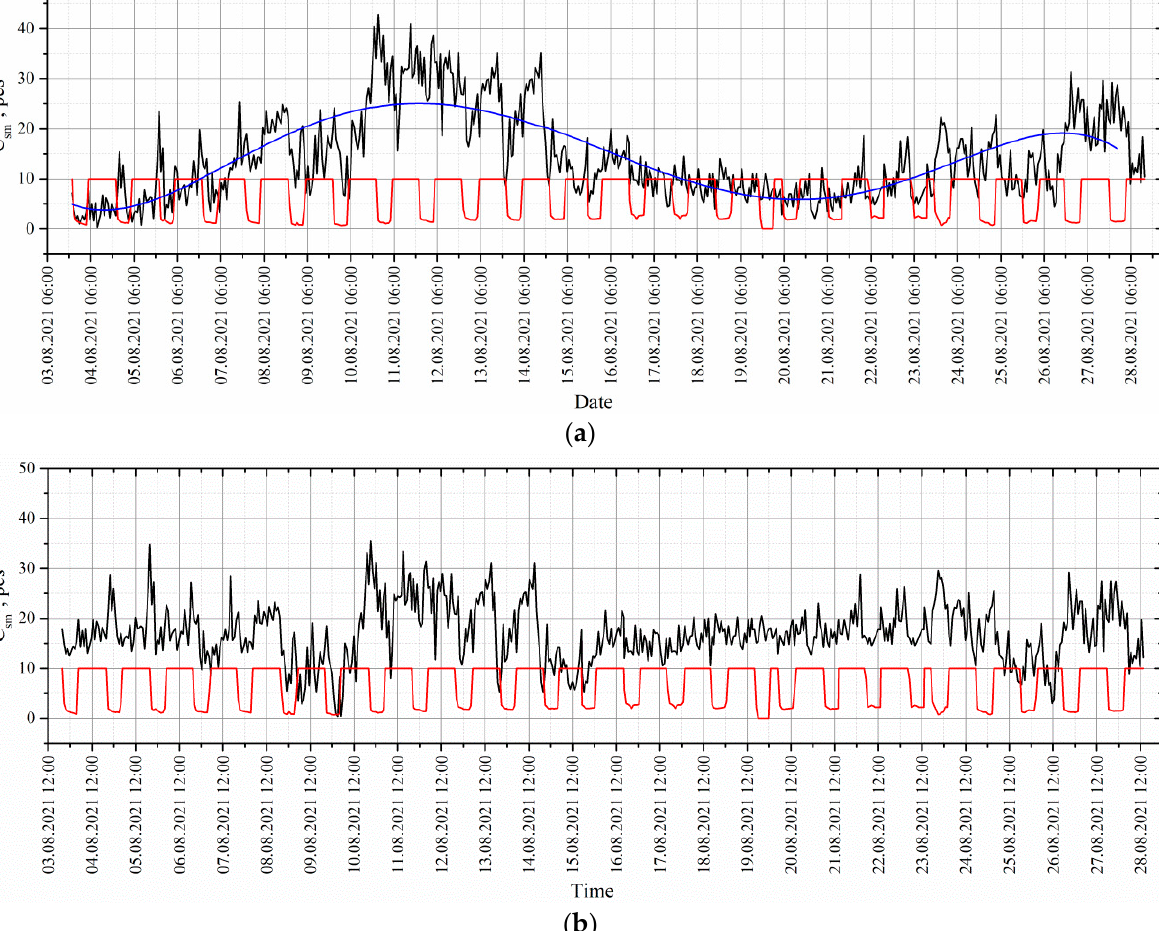
Figure 7. ( a )—time series of measurements formed by the DHC FOCL probe during moorage in Lake Baikal at Bolshiye Koty Scientific Research Station (Limnological Institute (LIN)) on 3–28 August 2021. Red line—operation of the day/night sensor. Blue line—regression line. ( b )—regularized series of measurements. C 0.02 sm